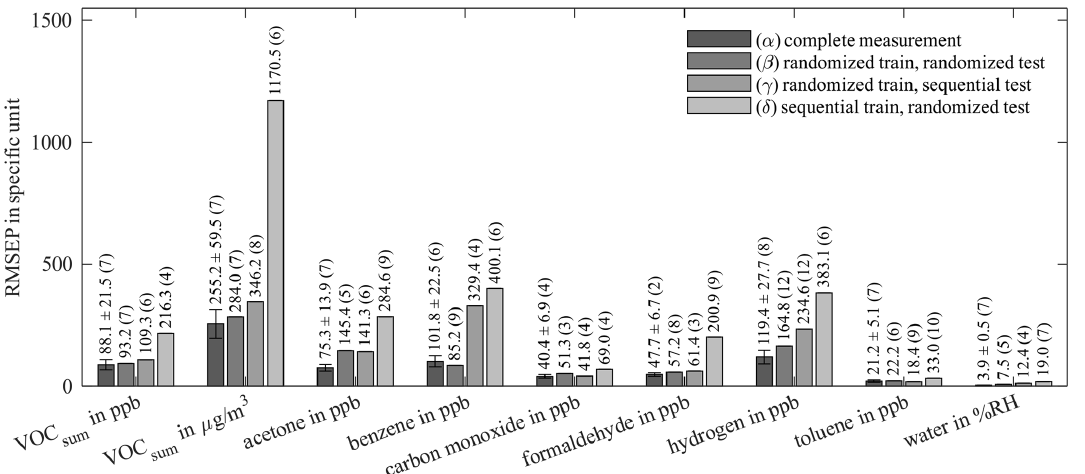
Figure 8. Root-mean-square error of prediction (RMSEP) of AS-MLV-P2 for different training and testing models. All models use 10- fold cross-validation for hyperparameter optimization; the resulting number of PLSR components, determined with Eq. (2), is given in parentheses. A detailed description of ( α )–( δ ) is given in Table